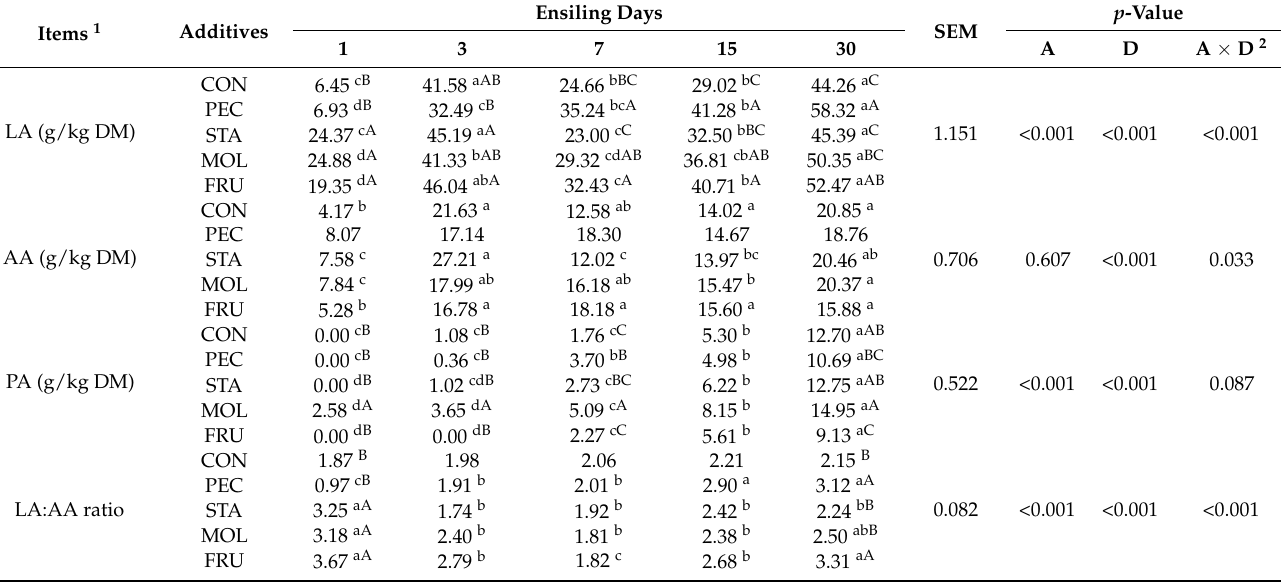
Table 2. The dynamics of organic acid concentrations of silage alfalfa during the entire ensiling period. Items 1